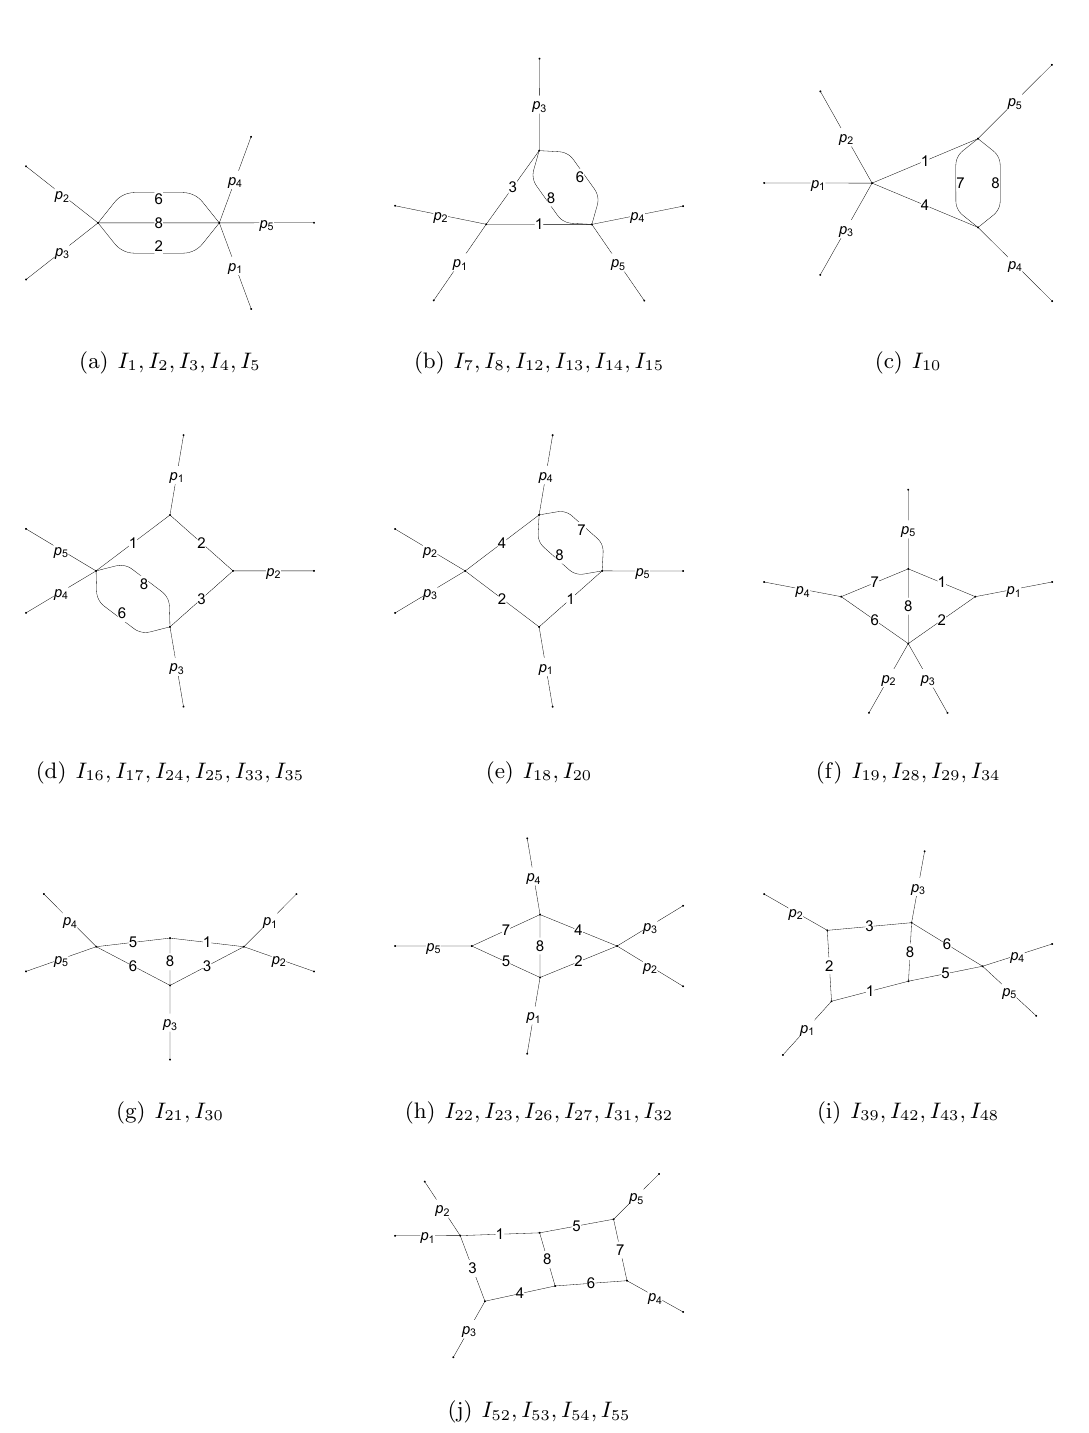
Figure 4 . Five-particle integrals in four-point kinematics. Graphs related by symmetries are not